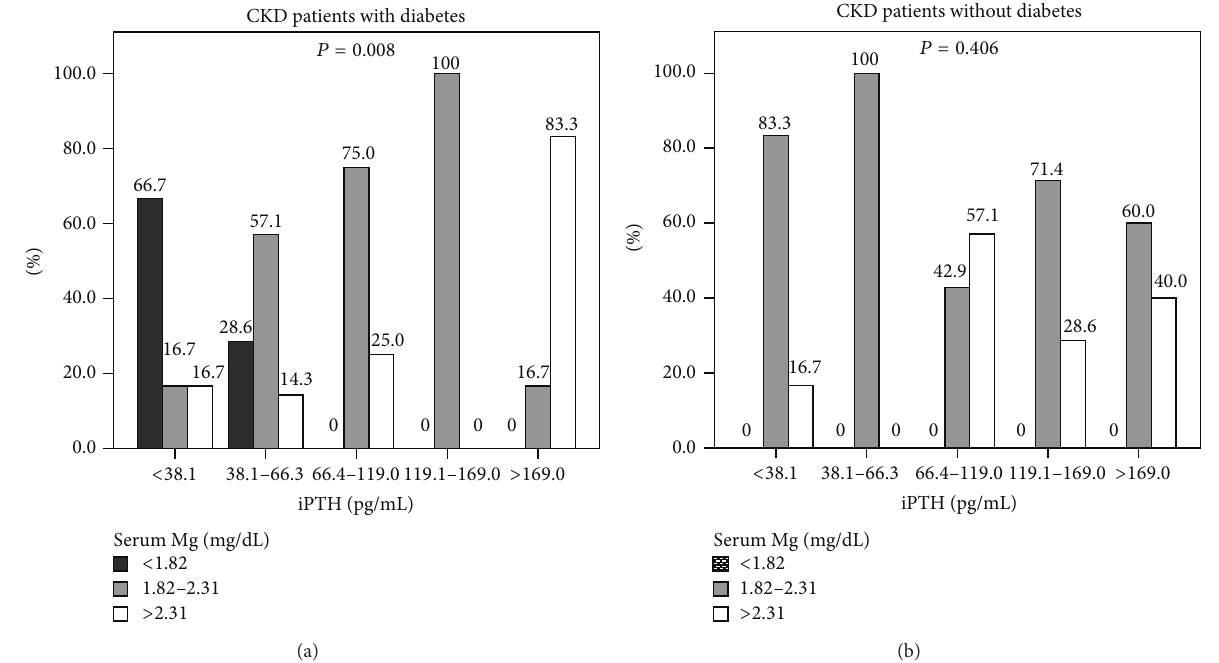
Figure 1: Correlation between serum Mg levels and iPTH levels. (a) CKD patients with diabetes. (b) CKD patients without diabetes. Comparisons of categorical data between two groups were analyzed by Chi-square test. When cells have expected count less than 5, data were analyzed by Fisher’s Exact test. Data are presented as percentage (%). A 𝑃 value less than 0.05 was considered statistically